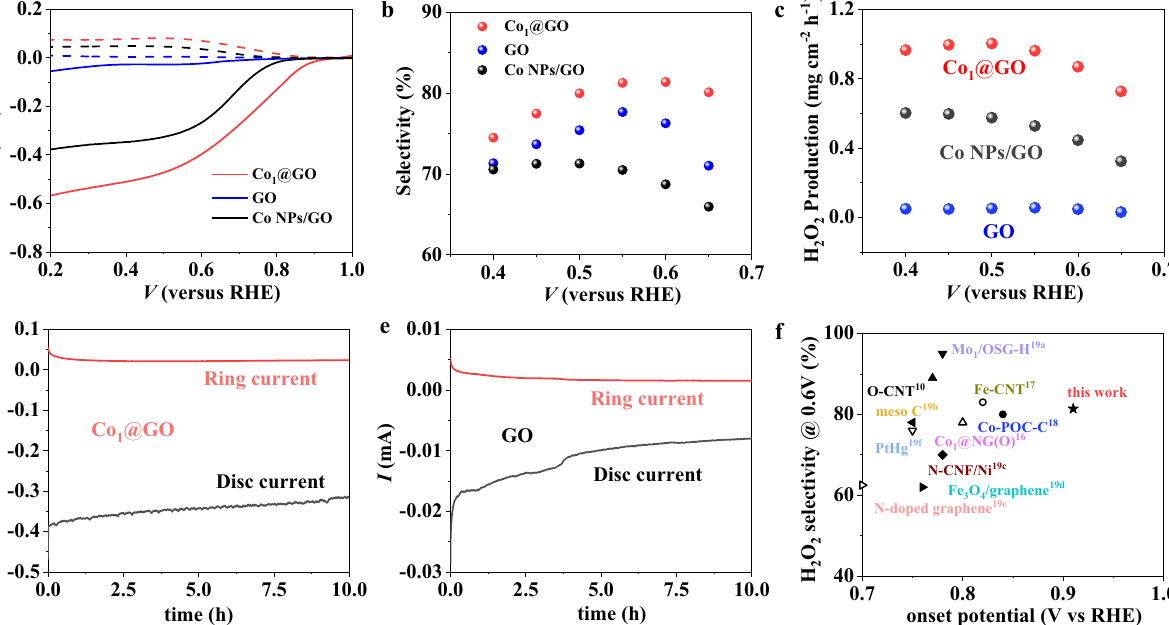
Fig. 4 Oxygen reduction performance of Co 1 @GO and GO. a , b Oxygen reduction performance of Co 1 @GO and GO in 0.1 M KOH at 1600 rpm (solid lines) and H 2 O 2 product currents (ring electrode, dashed lines). c Electrosynthesis of H 2 O 2 on Co 1 @GO and GO in O 2 ‐ saturated 0.10 M KOH electrolyte. d , e Stability tests of Co 1 @GO and GO at 0.1 M KOH. f Comparison of the onset potential and selectivity for electrosynthesis H 2 O 2 on Co 1 @GO and other reported catalysts at 0.6 V (RHE).